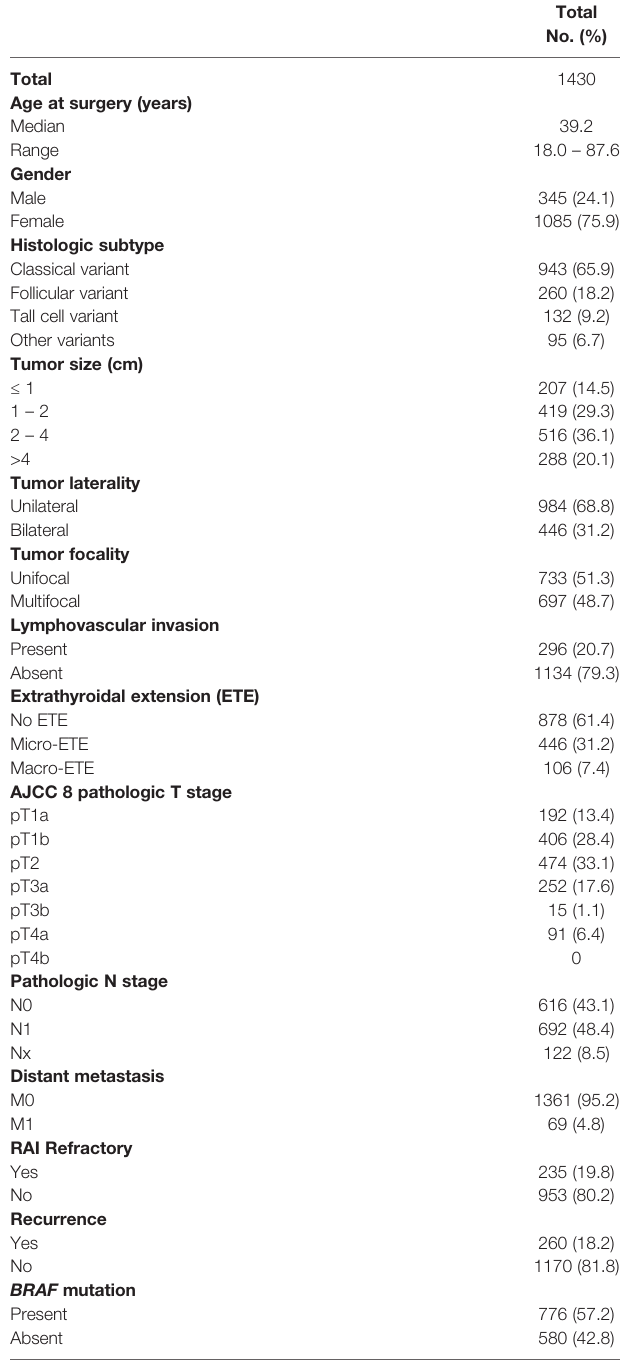
TABLE 1 | Patient characteristics of the PTC